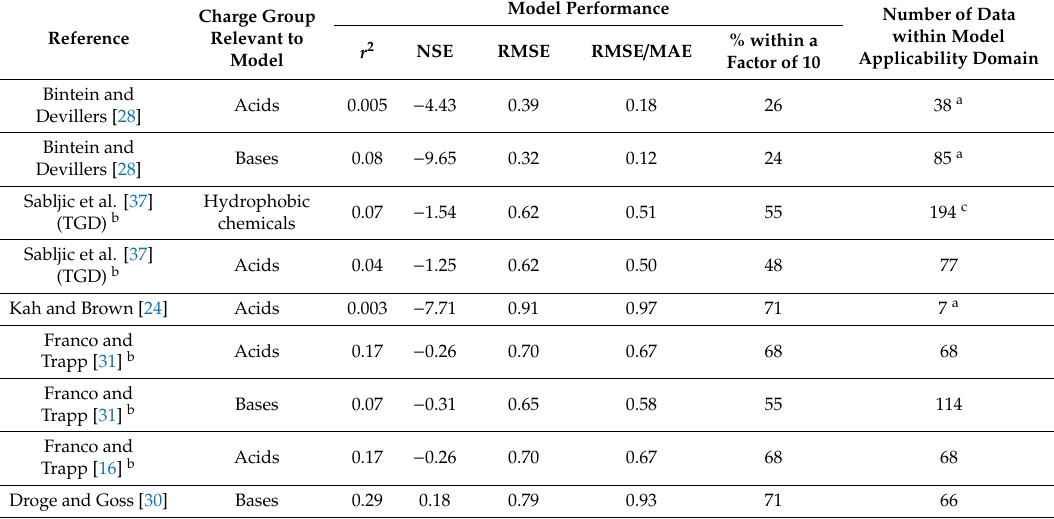
Table 3. Assessment of the performance of previously published soil sorption models in their ability to predict soil sorption coe ffi cients (log K d